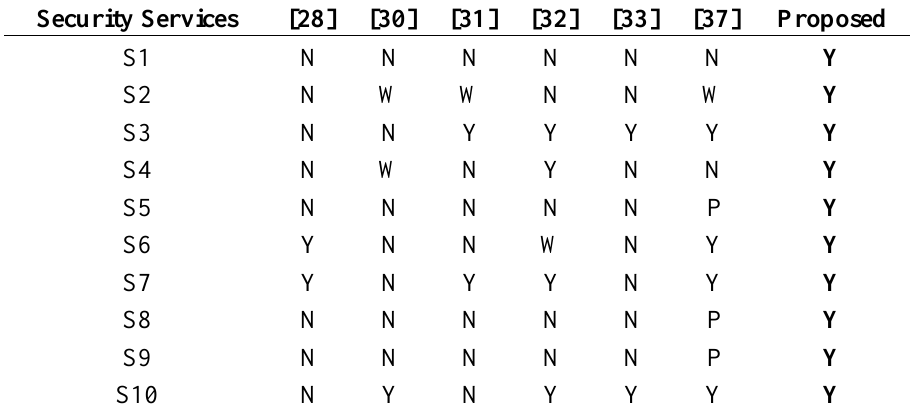
Table 2. Security services comparisons with the existing